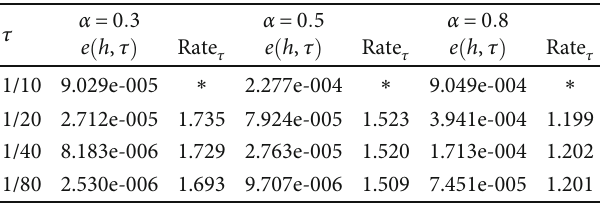
Figure 1: Error planes of Example 10, where τ = h = 1/100 Table 3: Simulation results of Example 11, where h = 1/2000 and α = 0 : 3,0 : 5,0 : 8 .